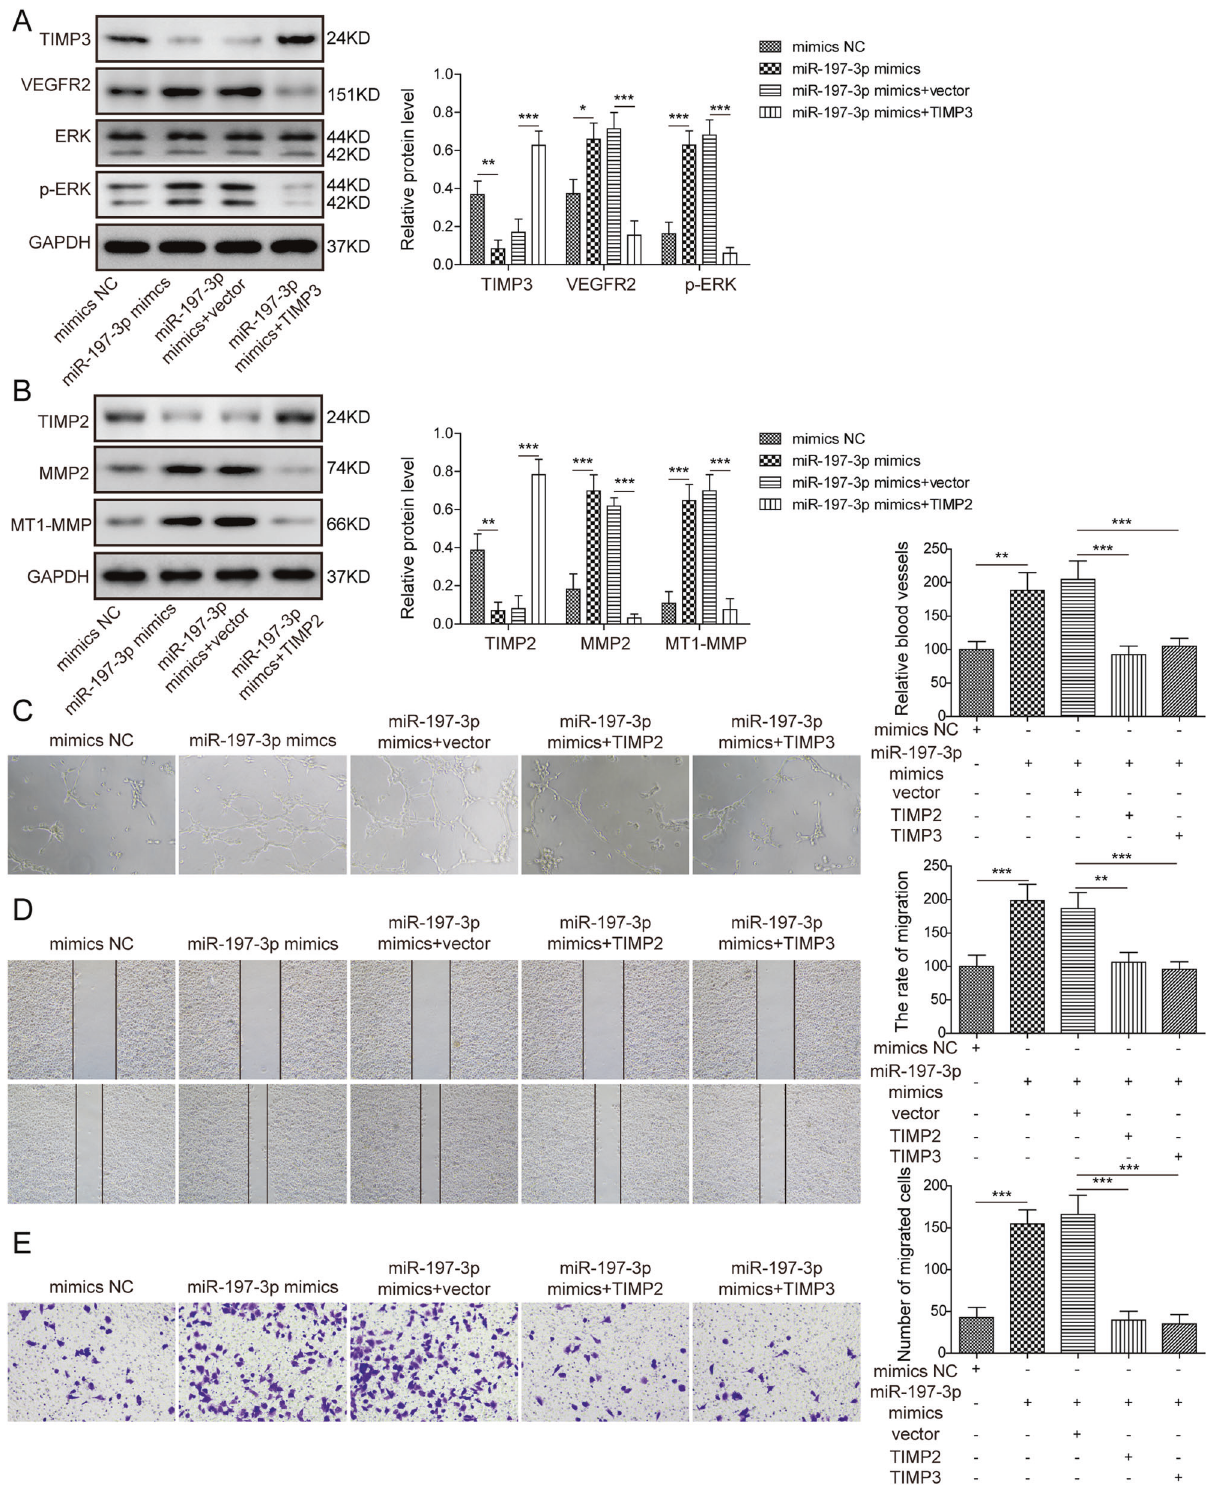
Fig. 6 MiR-197-3p promotes angiogenesis and migration in vitro by targeting TIMP2/3 in HUVECs. A The protein levels of TIMP3, VEGFR2, ERK and p-ERK in different HUVECs were determined by western blot. B The protein levels of TIMP2, MMP2 and MT1-MMP in different HUVECs were determined by western blot. C Angiogenesis was assessed by tube formation assay with quantitative analysis (right panel). D Cell migration was assessed by wound healing assay with quantitative analysis (right panel). E Migration of HUVECs was monitored by transwell migration assay with quantitative analysis (right panel). Data were representative images or were expressed as the mean ± SD of n = 3 experiments. * P < 0.05, ** P < 0.01, *** P < 0.001.